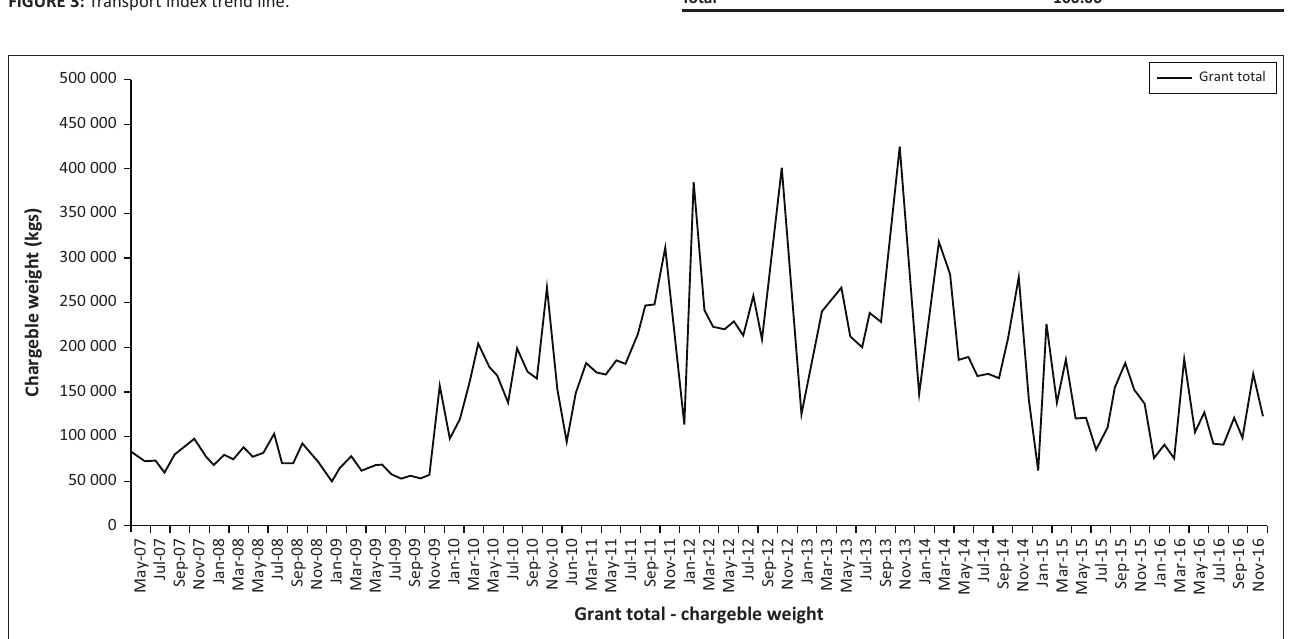
FIGURE 4: Total monthly volumes – May 2007 to December